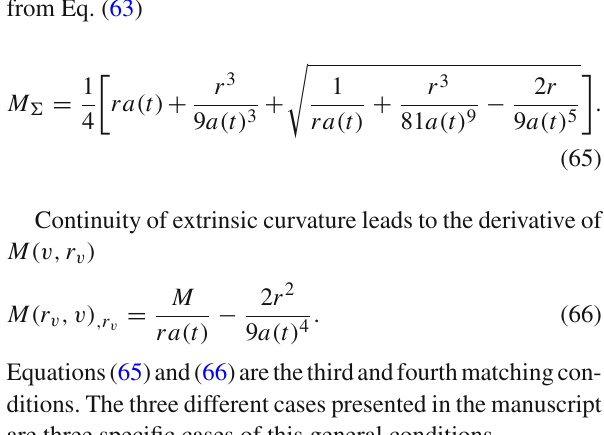
Fig. 10 Time evolution of the axion field for a 0 = 1, ρ 0 = 10, ψ 0 = 0 . 1. For the graph on top, the initial condition da < on bottom, da dt t = t i